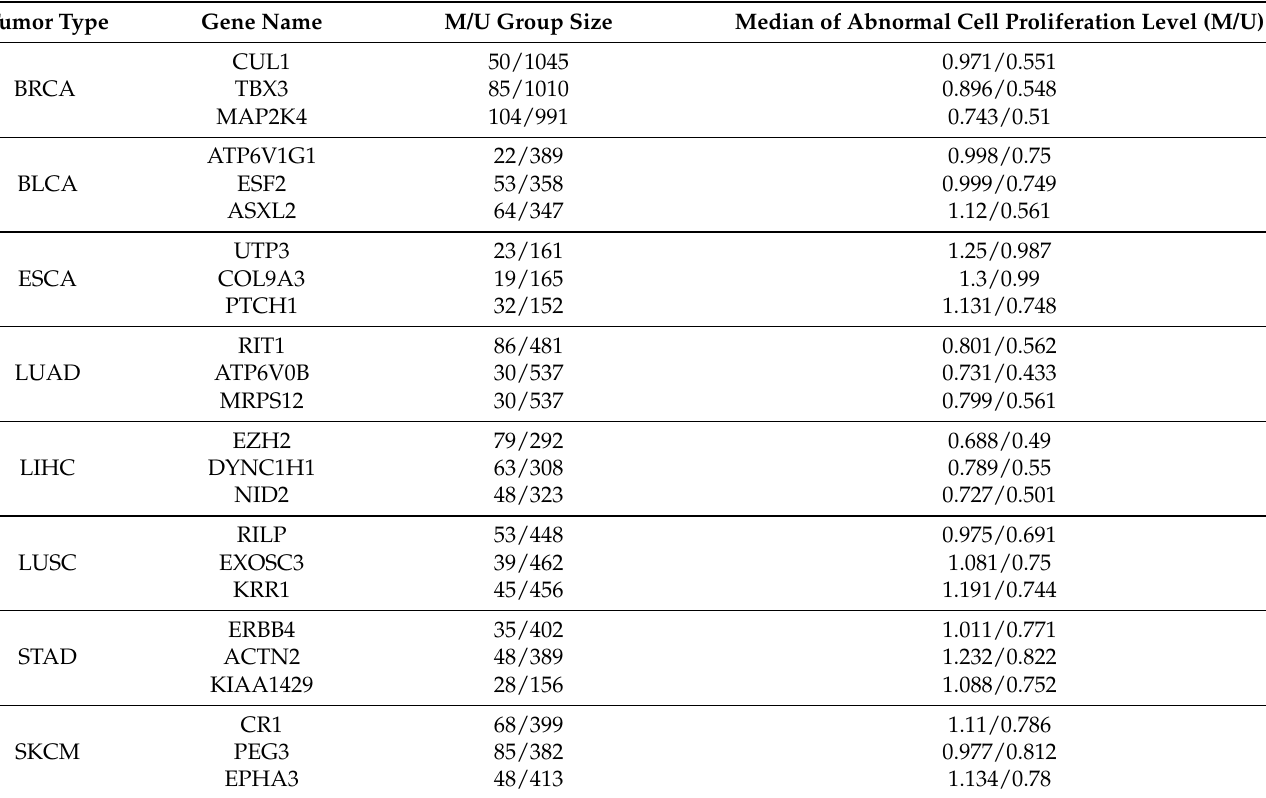
Table 4. Number of samples of NPCD mutant/nonmutant group and median of abnormal cell proliferation level of sample